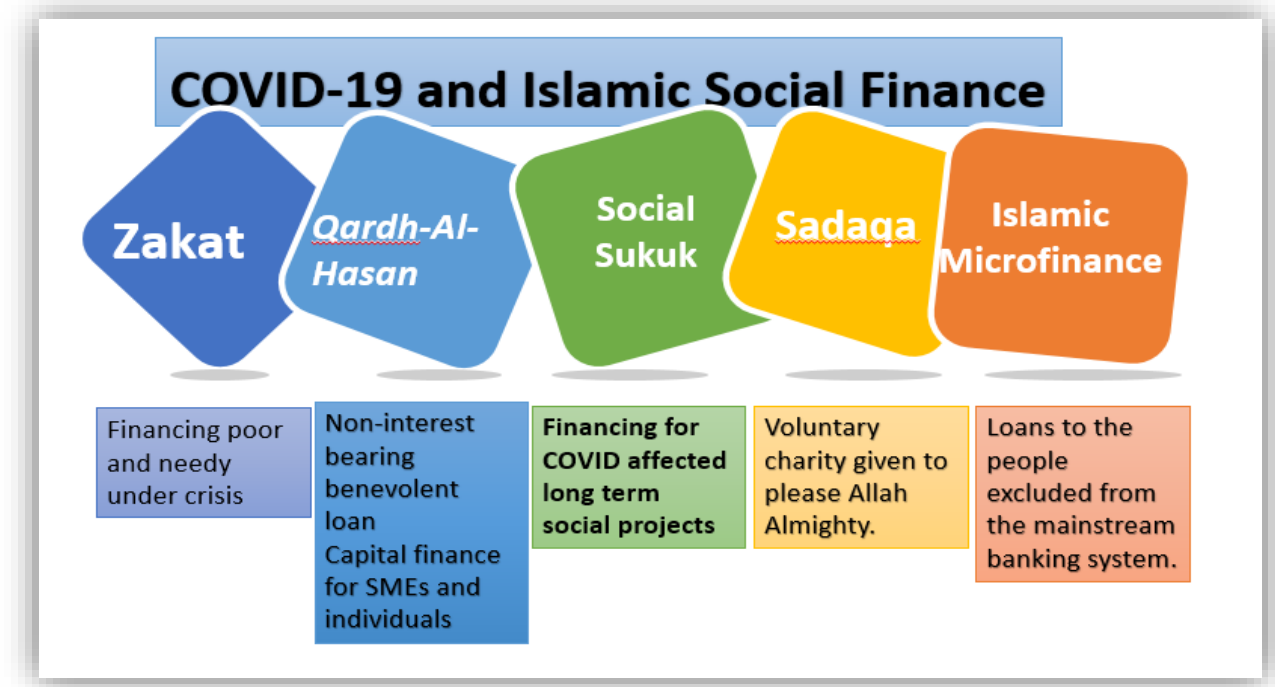
Figure 4. COVID 19 and Islamic social finance tools; Source-Author compilation.